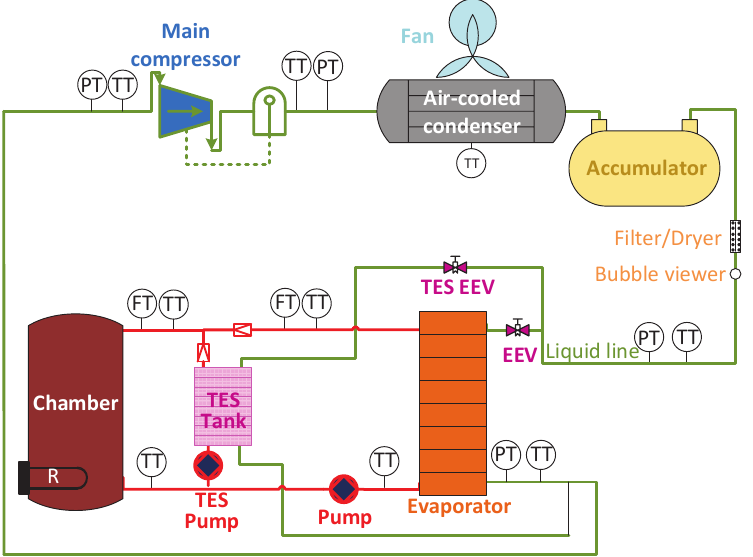
Figure 2. Layout of the TES-backed-up refrigeration plant under study. Two bundles of pipes run through the TES tank, corresponding to the refrigerant and the secondary fluid, respectively. An additional expansion valve is added to drive the refrigerant from the condenser (labelled as TES EEV in Figure 2), whereas an additional pump is needed to impulse the secondary fluid from the refrigerated chamber (labelled as TES Pump ). Notice that the elements defined in [28] as the main compressor, the air condenser, the evaporator related to the refrigerated chamber at − 20 ◦ C, and the corre- sponding expansion valve EEV2 are considered in this configuration, whereas the TES EEV is assumed to be identical to EEV2 . Further technical details about the embedding of the TES tank are described in